Question: Express in one sentence what the figure is showing.
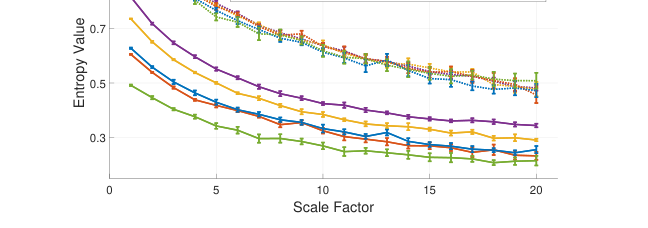
Answer: Correlated noise entropy across various structures, ranging from uncorrelated to fully connected across scale factors.